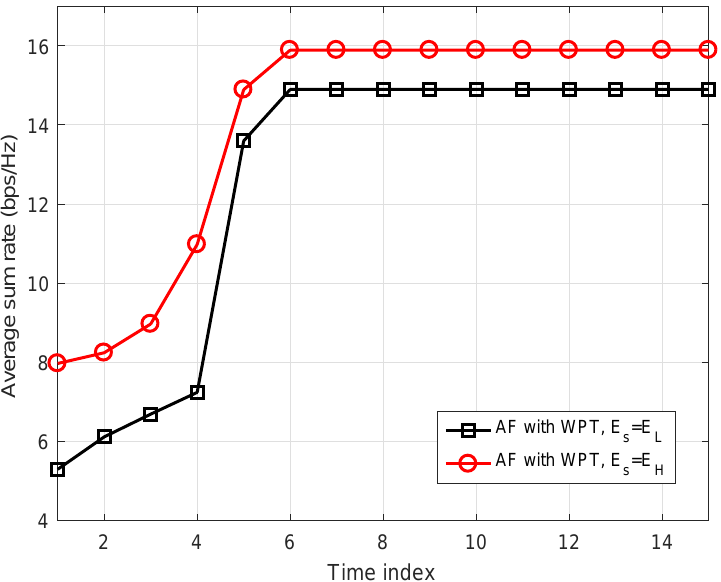
Figure 4. Scenario 2 ( E s ≥ E r ): Average sum rate performance vs. time index ( N = 4, d sr = 1 m and d rd = 50